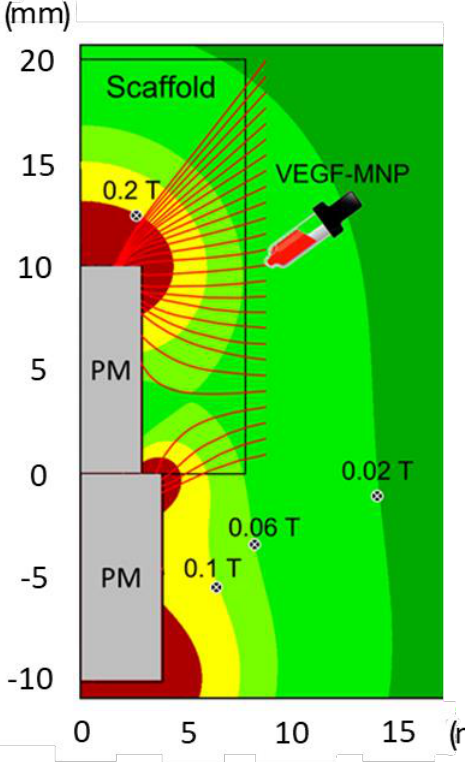
Figure 1. Trajectories (red lines) of VEGF-MNPs injected near the scaffold surface. The color distribu- tion shows isolines of the magnetic field (B = 0.02–0.2 T) near the scaffold and permanent magnets (PMs).